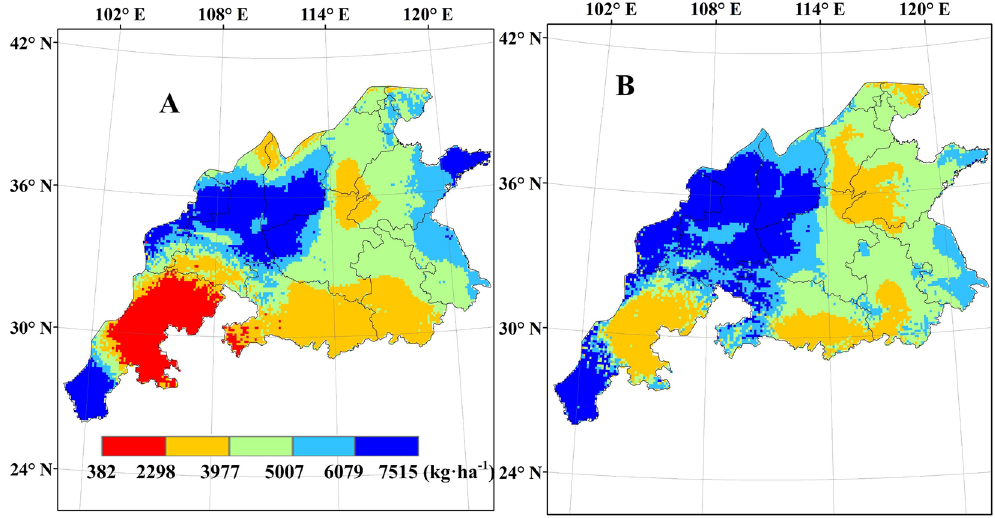
Figure 9. Average yield gap (Yg) percentage from 1998 to 2008 in the main winter wheat production regions of China, ( A ) CERES-Wheat; ( B ) WheatGrow (This figure was created by ArcGIS 9.3, http://www.esri.com/